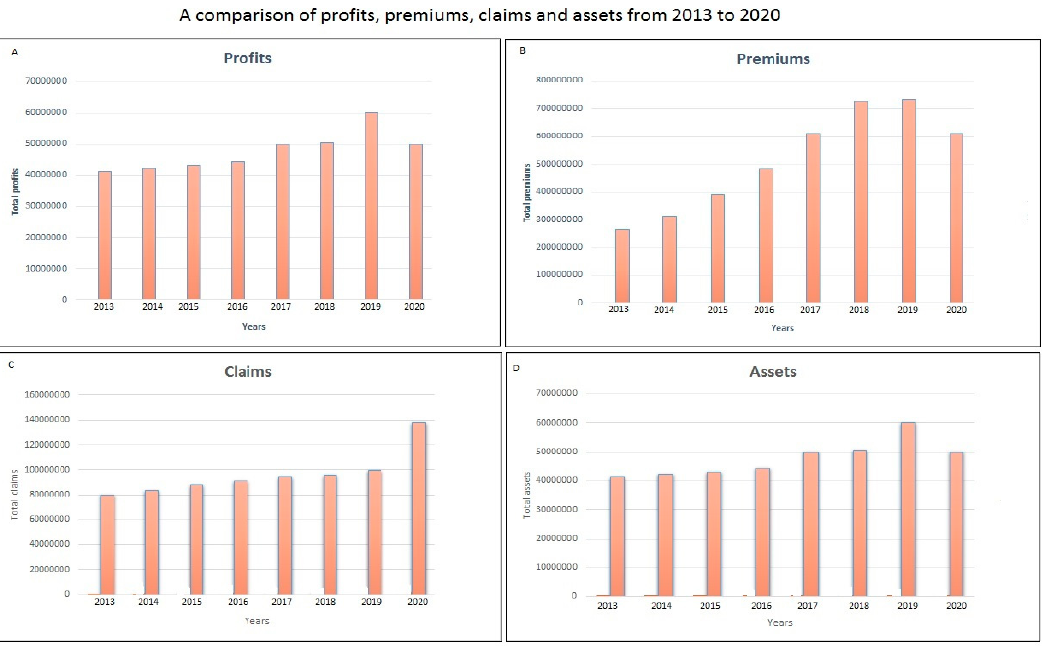
Figure 1. General quarterly (March to June) outlook of the insurance industry: ( a ) trend of profits, ( b ) trend of premiums, ( c ) trend of claims and ( d ) trend of assets.